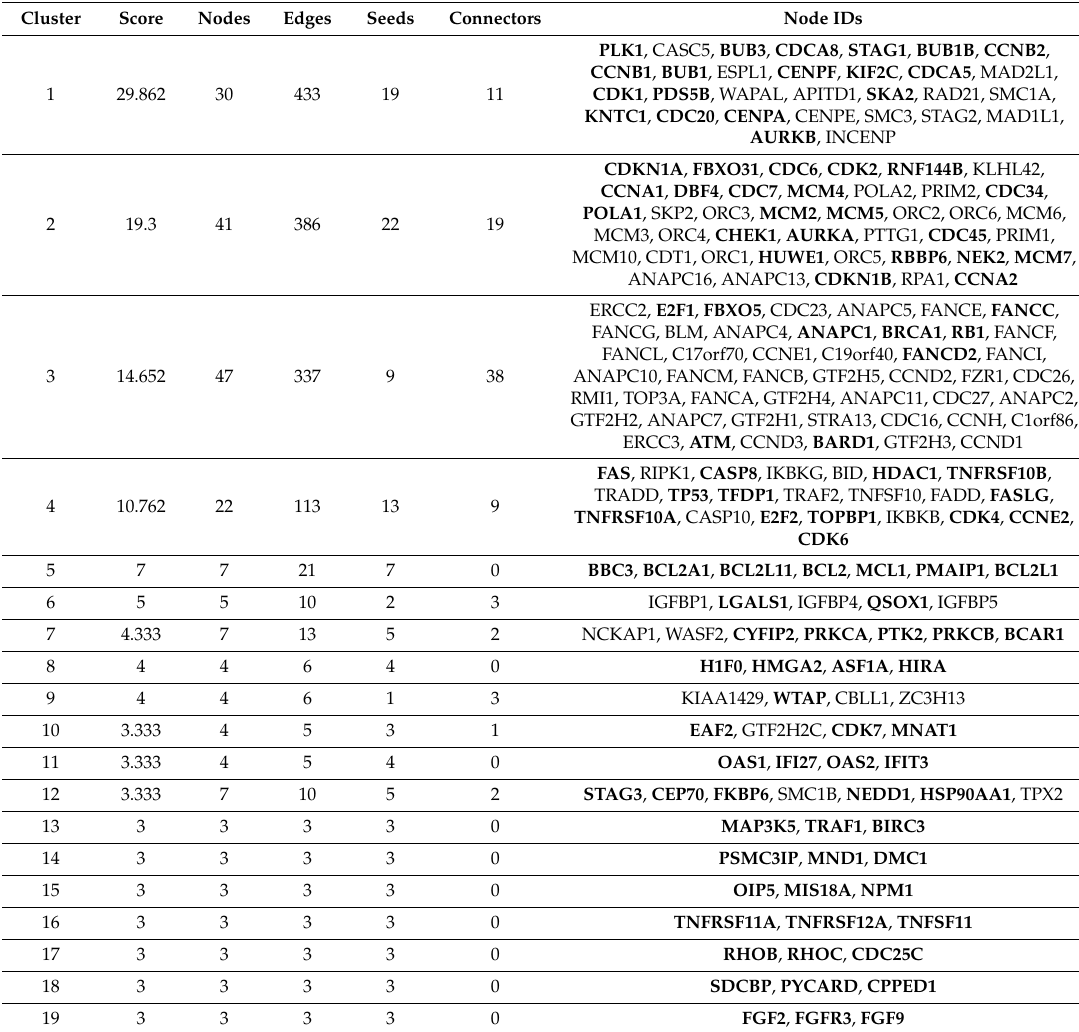
Table 1. Generated clusters with MCODE scores, seeds (bold letters), and connector (non-bold letters)